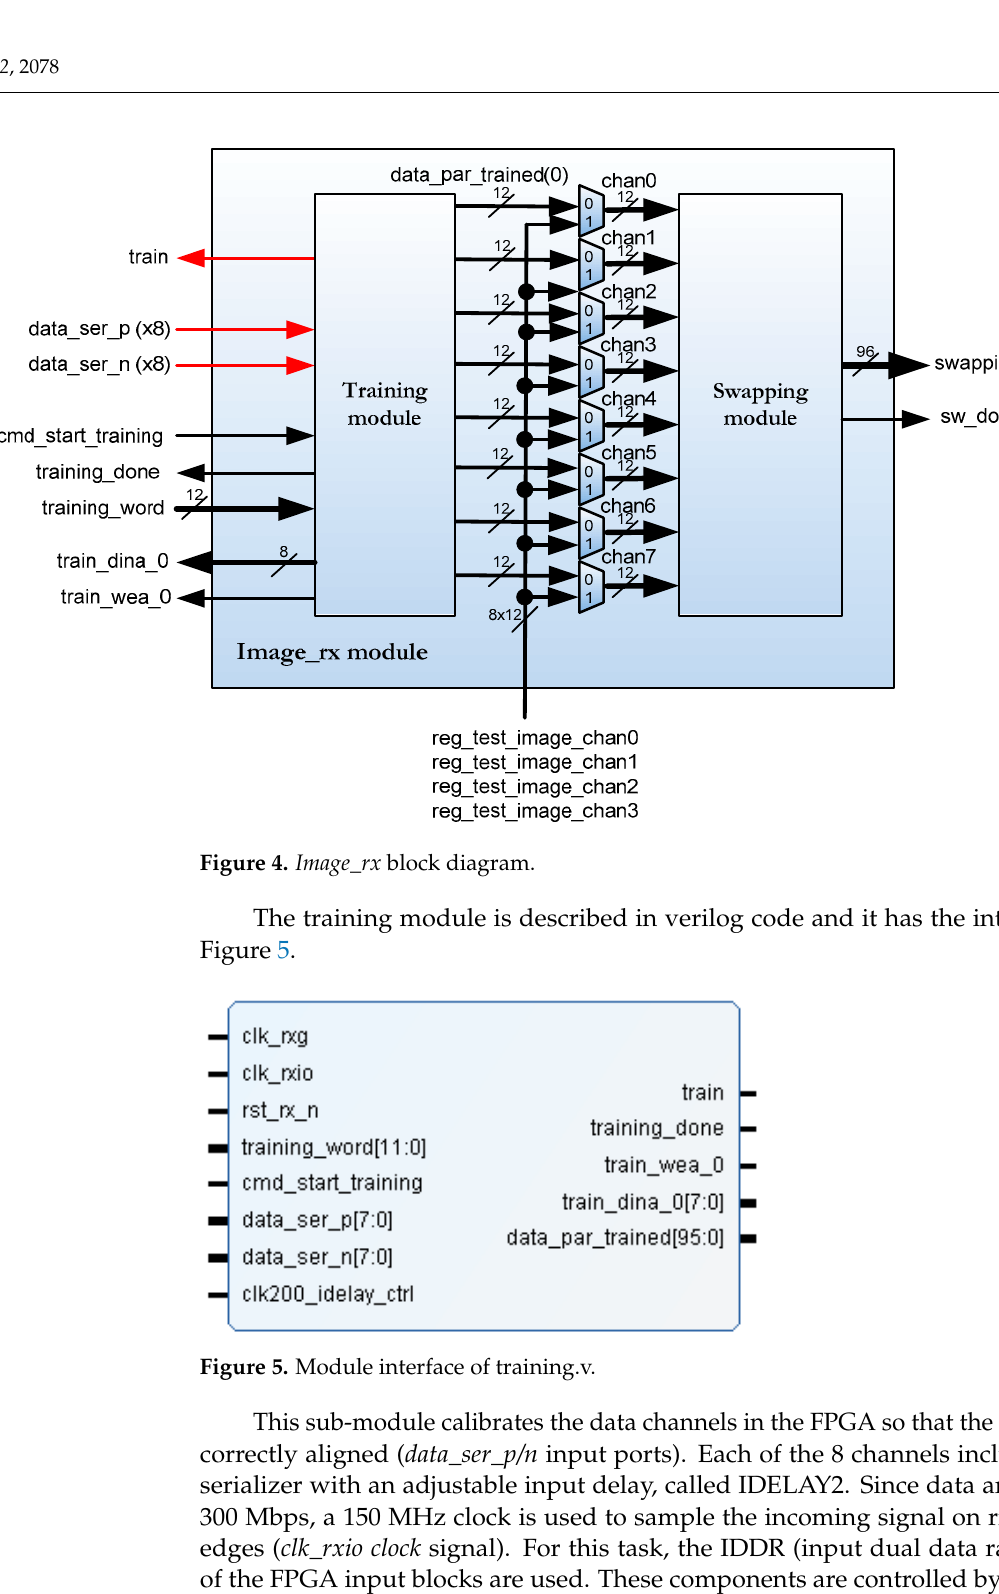
Figure 5. Module interface of training.v.